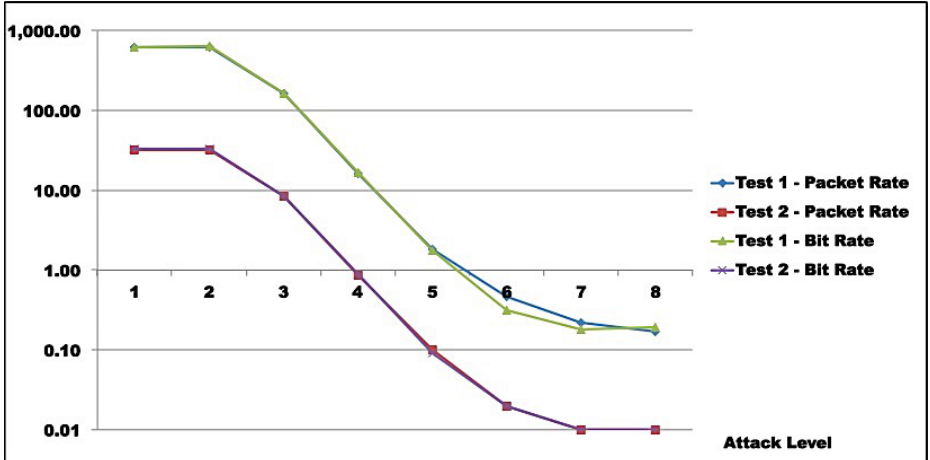
Figure 15. Reflector amplification factor in Bits, γ bit , and Packets, γ pkt , by attack